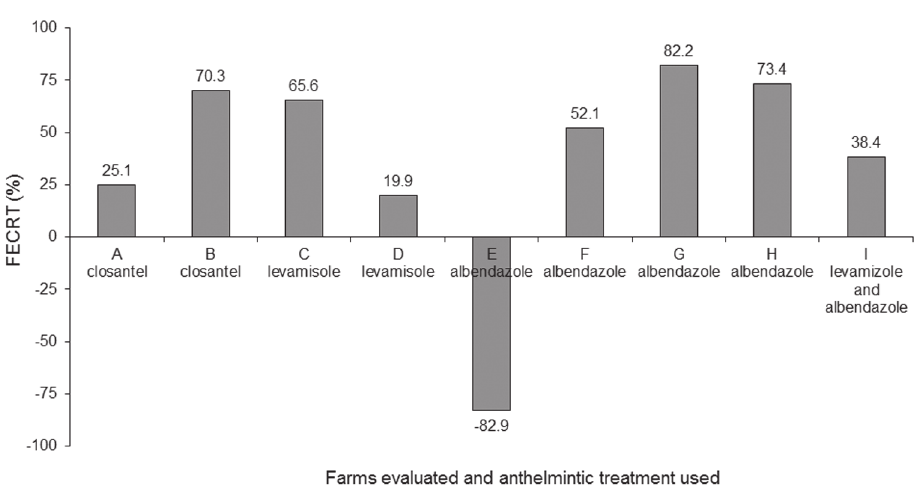
Figure 1 - The fecal egg count reduction test (FECRT) on farms in western Santa Catarina, when we tested the efficacy of anthelmintics to closantel (Farms A and B ), levamisole (Farms C and D ), albendazole (Farms E , F , G and H ) and combination of levamisole and albendazole (Farm I). *FECRT less than 95% represents the occurrence of anthelmintic resistance.